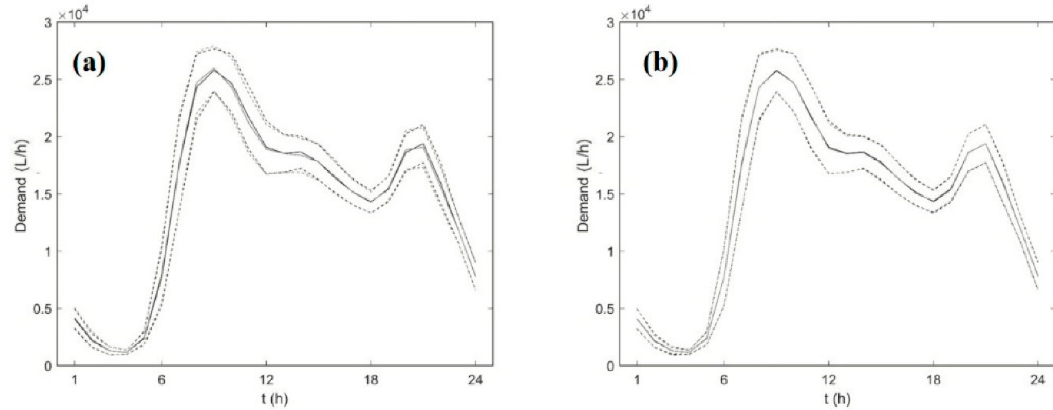
Figure 6. Daily temporal patterns of both mean μ (continuous lines) and intervals μ ± 0.5 σ (dotted lines) for measured (black lines) and generated (grey lines) aggregated demands: the generated demands were obtained applying the top-down approach ( a ) and the bottom-up approach ( b ), respectively [16].